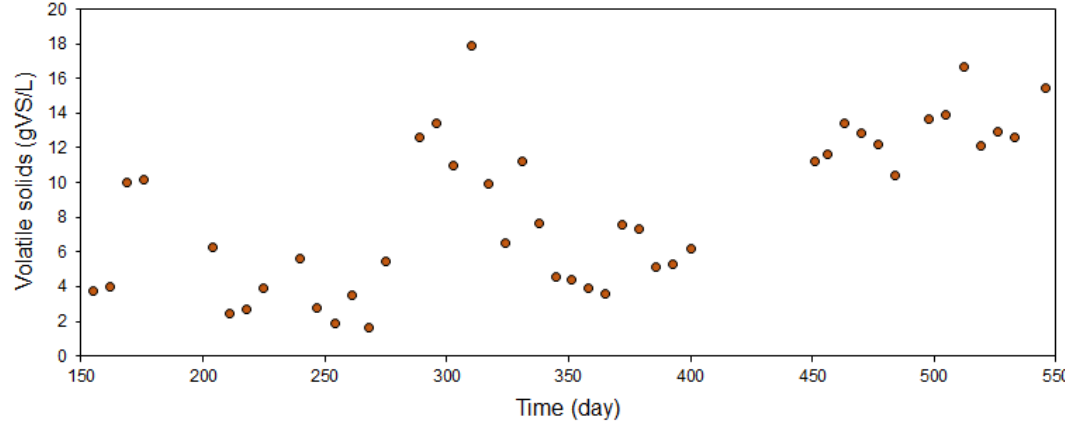
Figure 3. Concentration of volatile solids (VS) of thickened microalgal biomass.